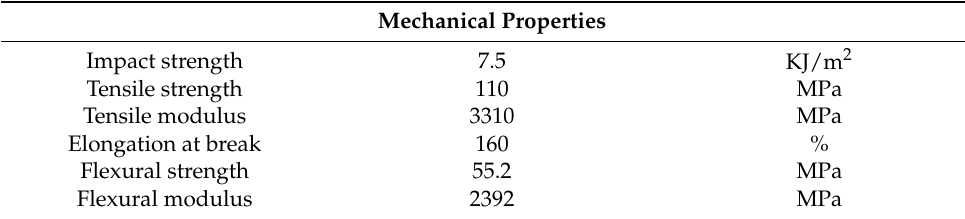
Table 1. Mechanical properties of 3D-printed PLA